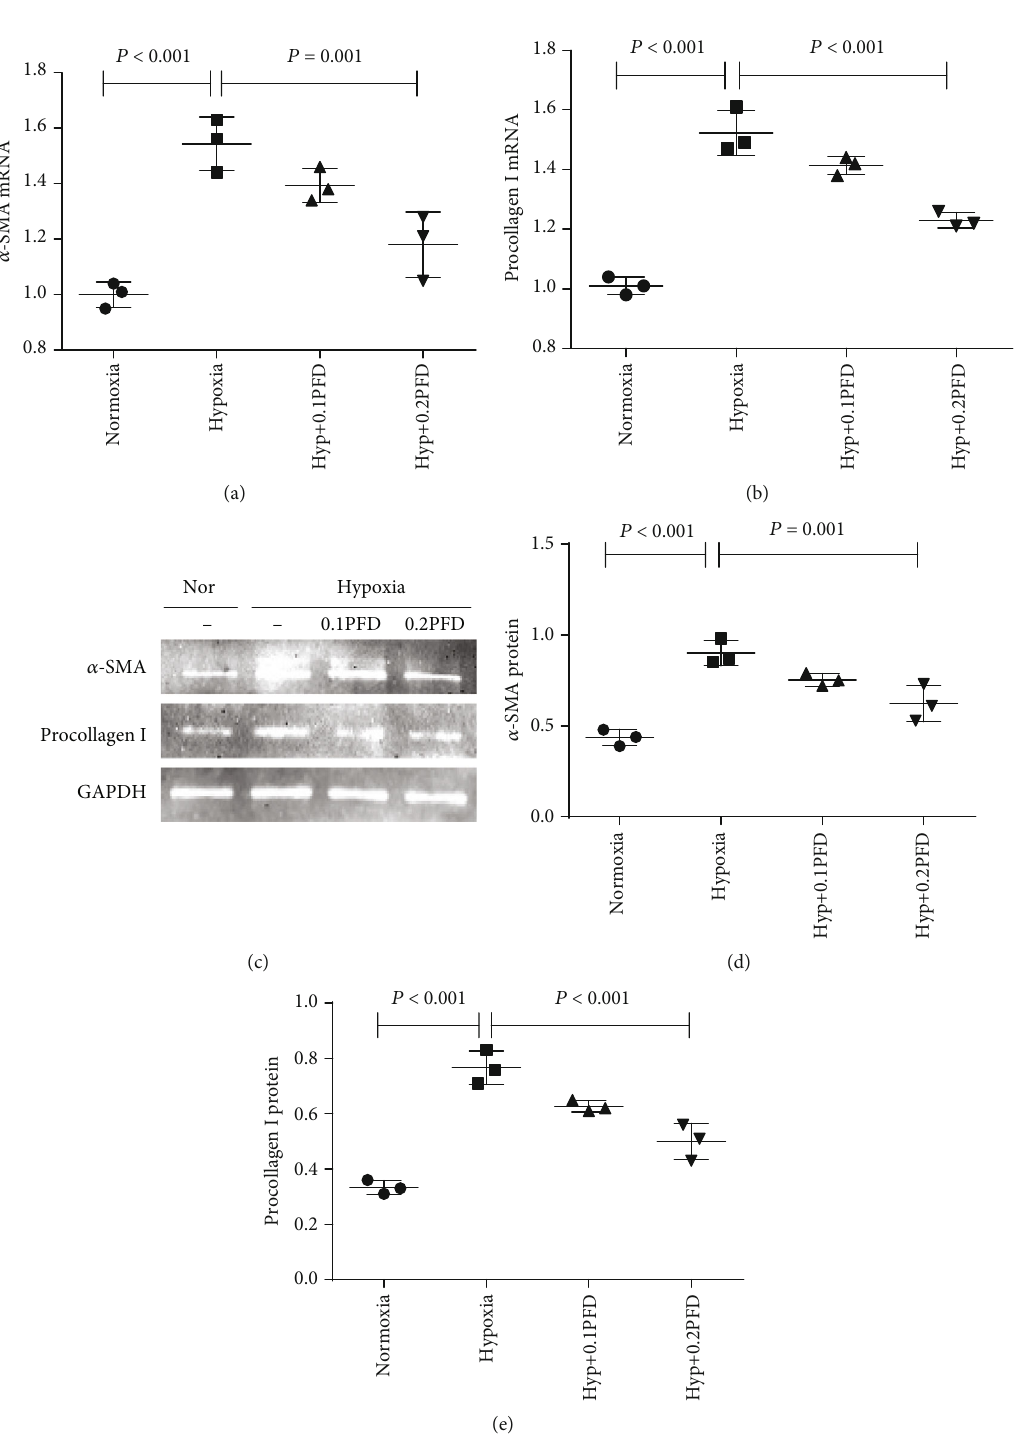
Figure 3: PFD signi fi cantly inhibited the mRNA and protein expression of a-SMA and procollagen I (COL1A1). (a, b) The mRNA expression of a-SMA and procollagen I (COL1A1) was assessed by RT-PCR. (c – e) The protein expression of a-SMA and procollagen I (COL1A1) was assessed by western blot analysis. Nor: normoxia; Hyp: hypoxia; PFD: pirfenidone; a-SMA: smooth muscle